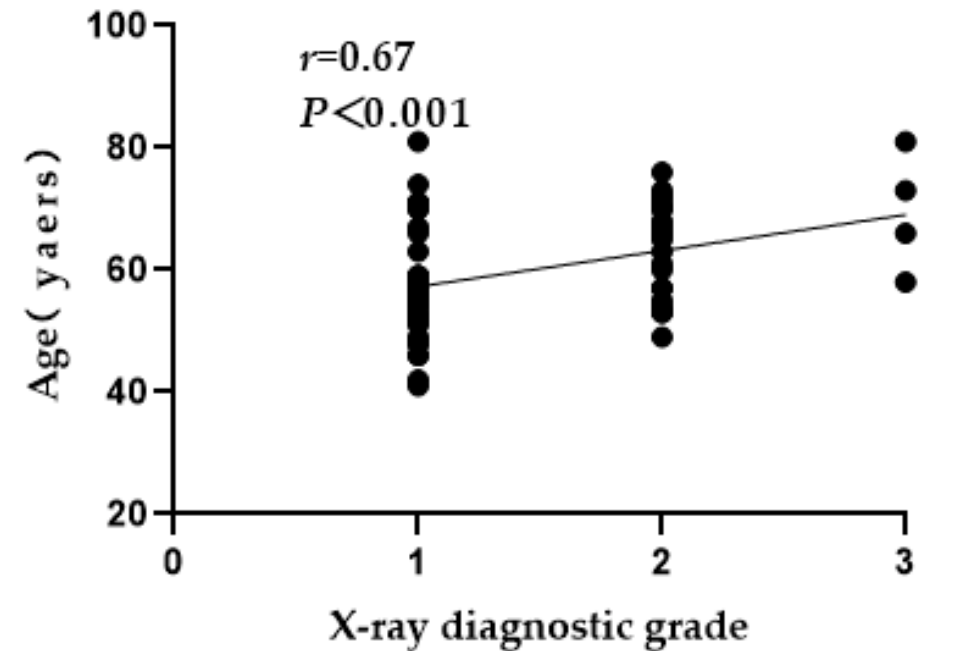
Figure 2. Correlation analysis of X-ray diagnostic grade with age among SF patients. Group 1: mild ( n = 36), Group 2: moderate ( n = 20); Group 3: severe ( n = 4). Table 2. X-ray grade analysis of SF patients ( n = 60) of different ages and sexes.